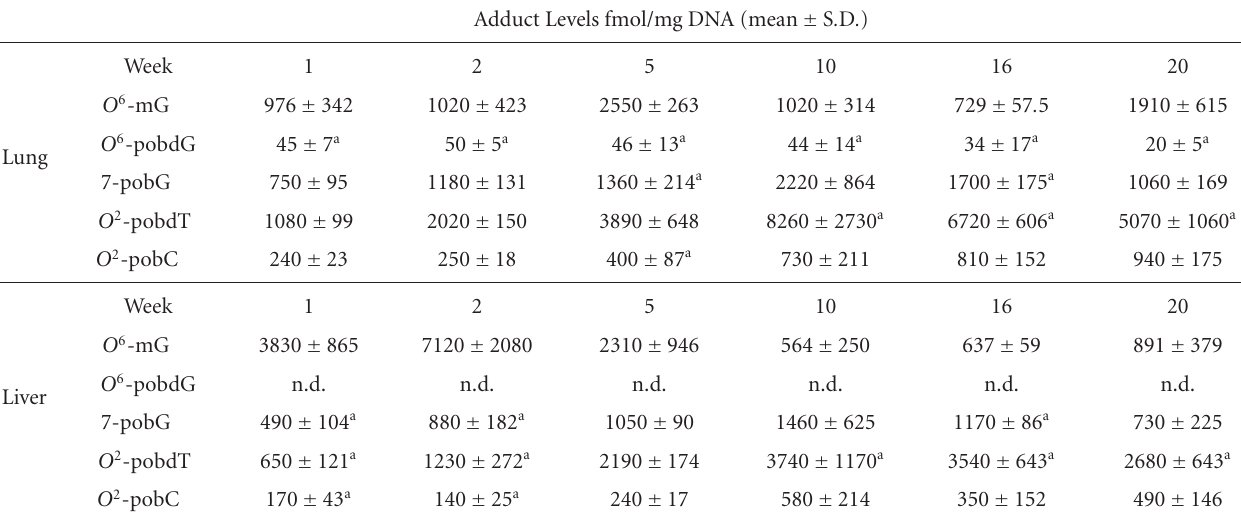
Table 2: Comparative DNA adduct levels in lung and liver of F344 rats treated with 10ppm NNK in the drinking water and sacrificed at various intervals [57,